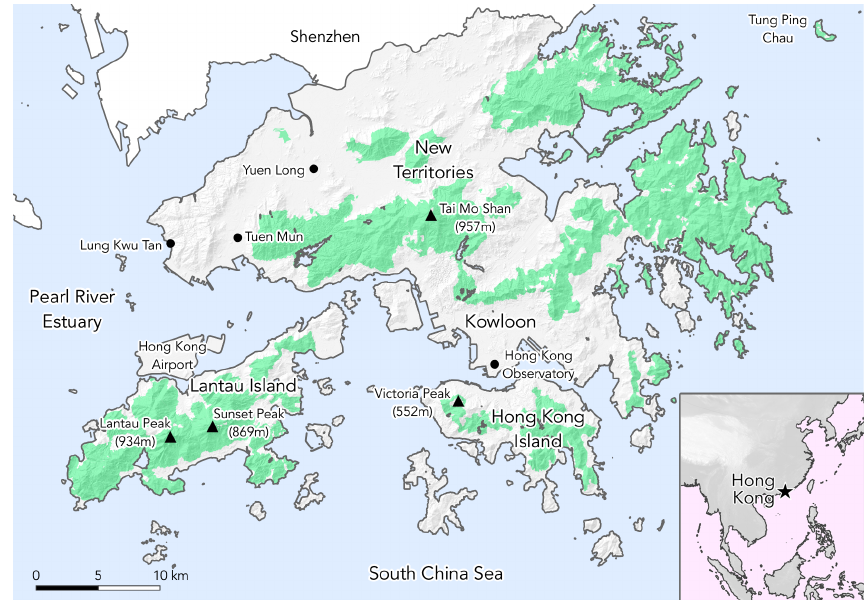
Figure 1. Hong Kong geography. The three highest peaks in the territory as well as the highest point on Hong Kong Island are marked. Areas protected as Country Parks are highlighted in